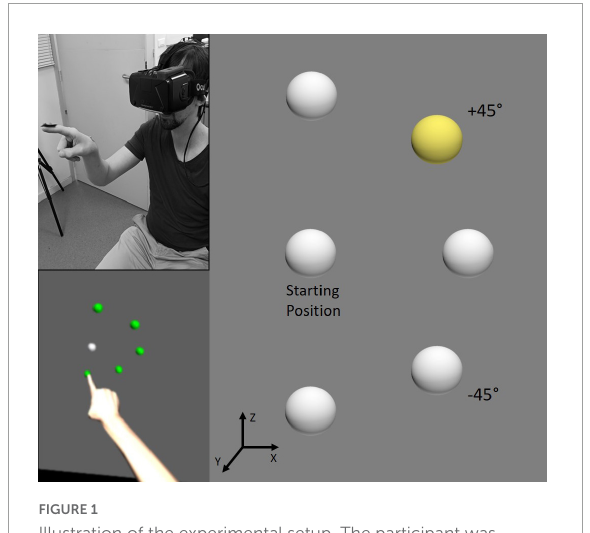
FIGURE1 Illustration of the experimental setup. The participant was equipped with an Oculus Rift and was required to point to one of five spherical targets in the virtual environment. All targets were equidistant from the starting position and located up, up right (+45 ◦ ), right, bottom right (–45 ◦ ) or at the bottom. In the visual block, the target to point was indicated by a change of color of the sphere from gray to yellow (as illustrated on the right panel for the +45 ◦ target), whereas in the verbal block the instruction was delivered auditorily. Feedback was provided by coloring all spheres in green (see the bottom left panel for another trial) for correct pointing, and in red for incorrect pointing.